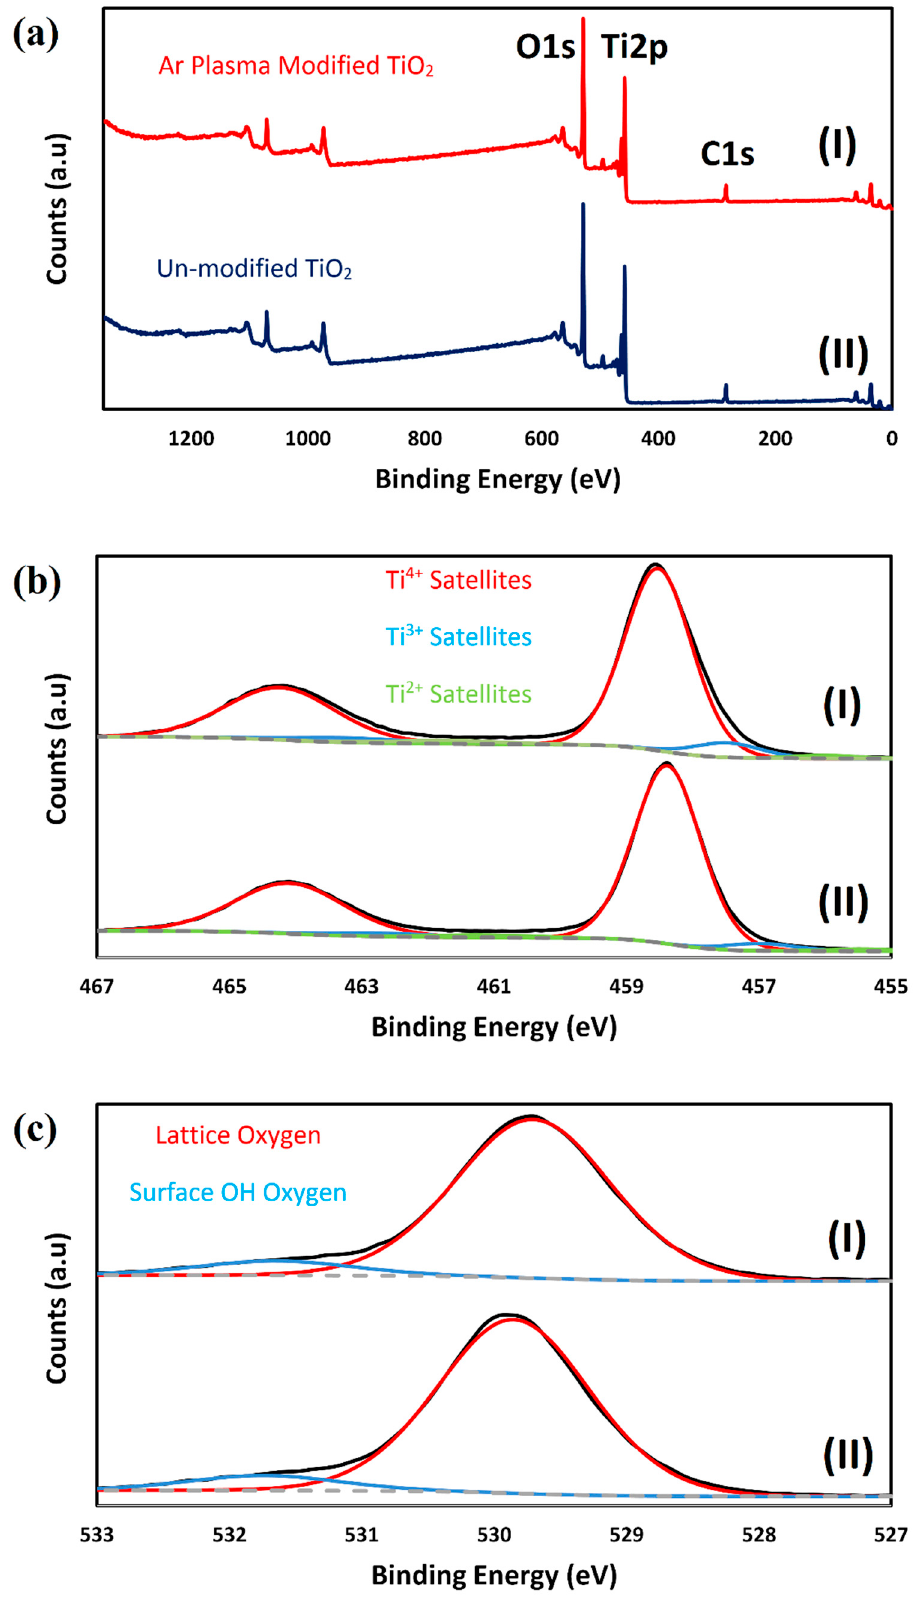
Figure 5. XPS spectra of plasma-treated (I) and non-treated TiO 2 (II): ( a ) Wide scan spectra; ( b ) HR-XPS spectra of Ti2p; ( c ) HR-XPS spectra of O1s.